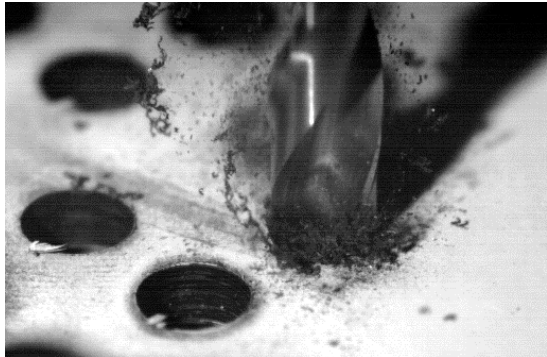
Figure 1. Evacuation of the composite material by dry OSD.